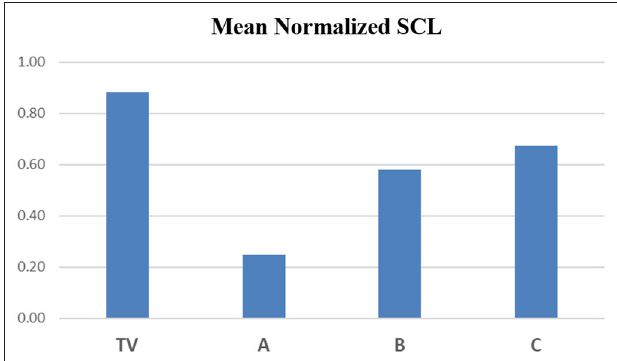
FIGURE 9 | Mean values of normalized SCL from the four limb sensors during Cold2’s Region